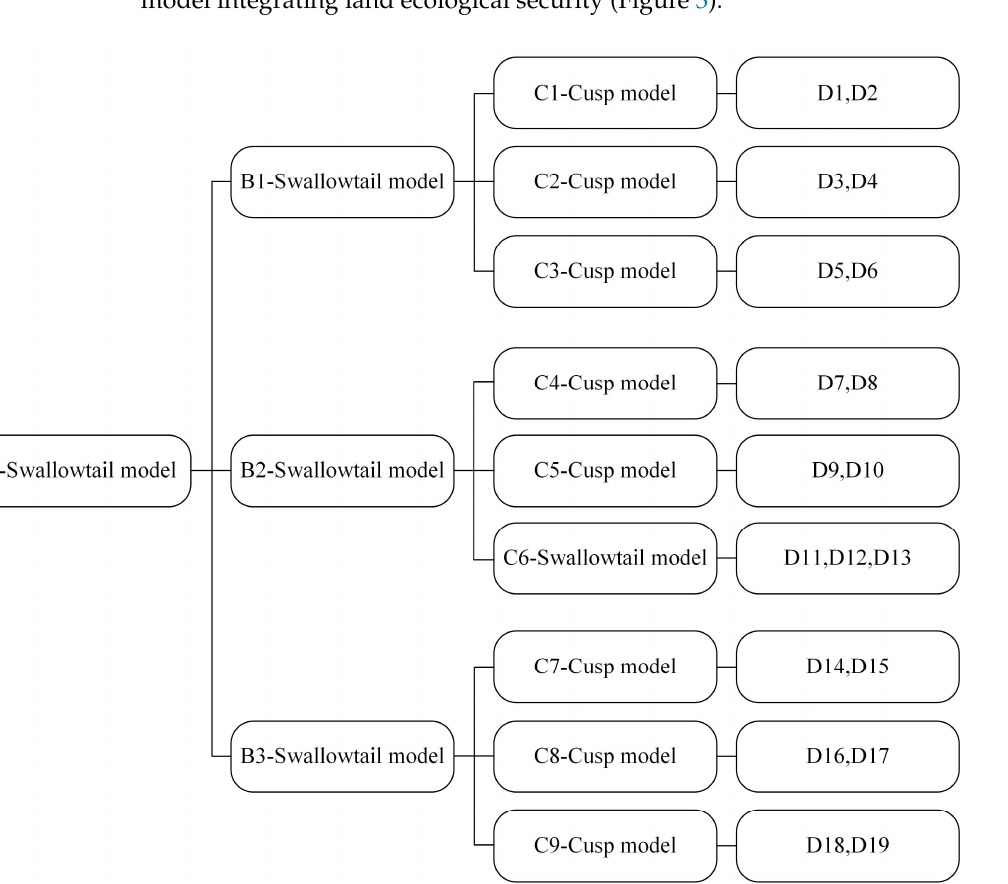
Table 2. Index system of LES evaluation.